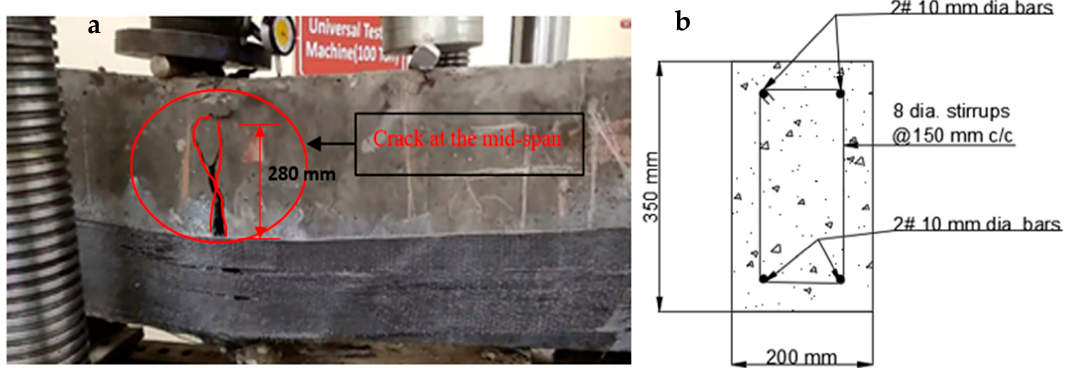
Figure 20. ( a , b ) Failure of the strengthened beam in the vertical direction.